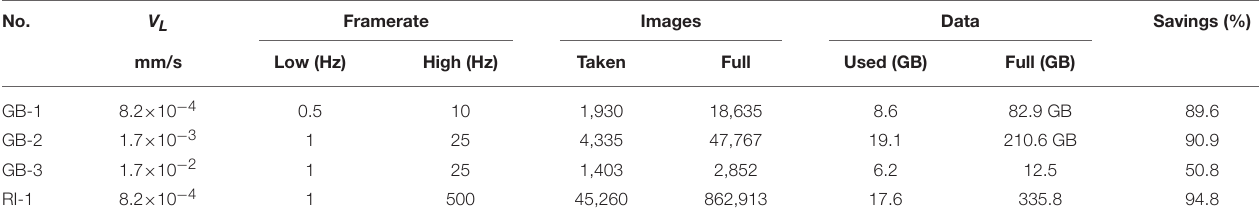
TABLE 2 | Recording rates and data savings per